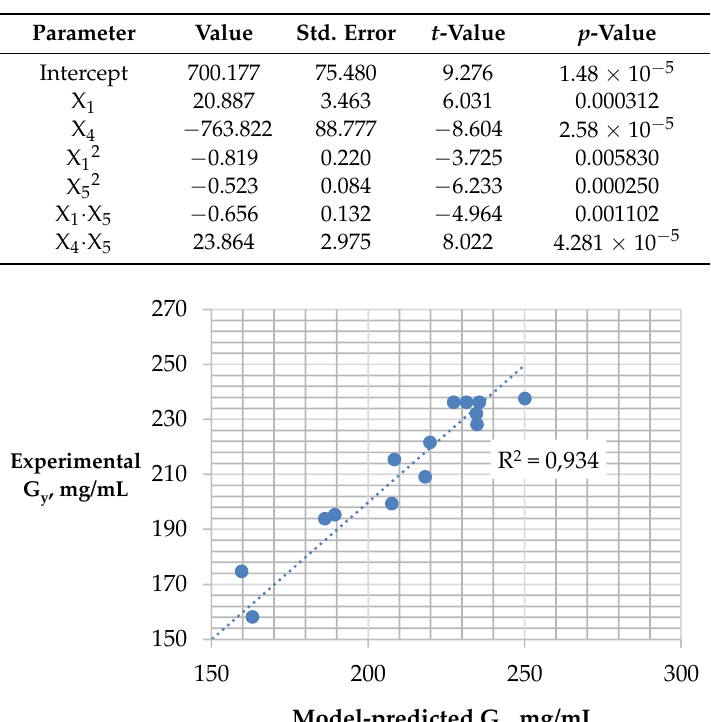
Table 6. Model parameters for the Box-Behnken design for alkaline pre-treatment and enzymatic hydrolysis of Triticum sp.